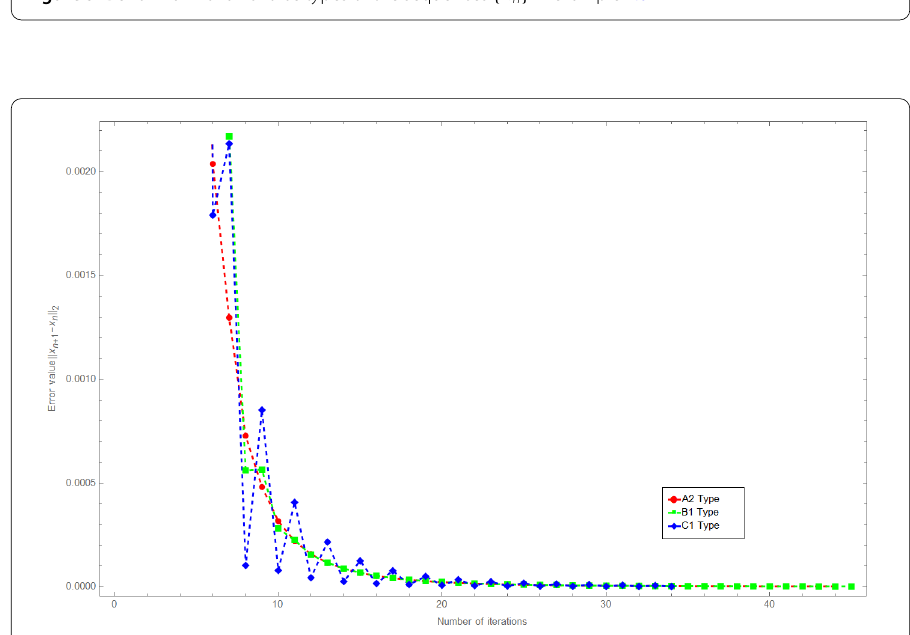
Figure 6 Convergence behavior of the error sequences {(cid:13) x n +1 – x n (cid:13) 2 } for all the best choice types A2, B1, and C1 in Example 4.8